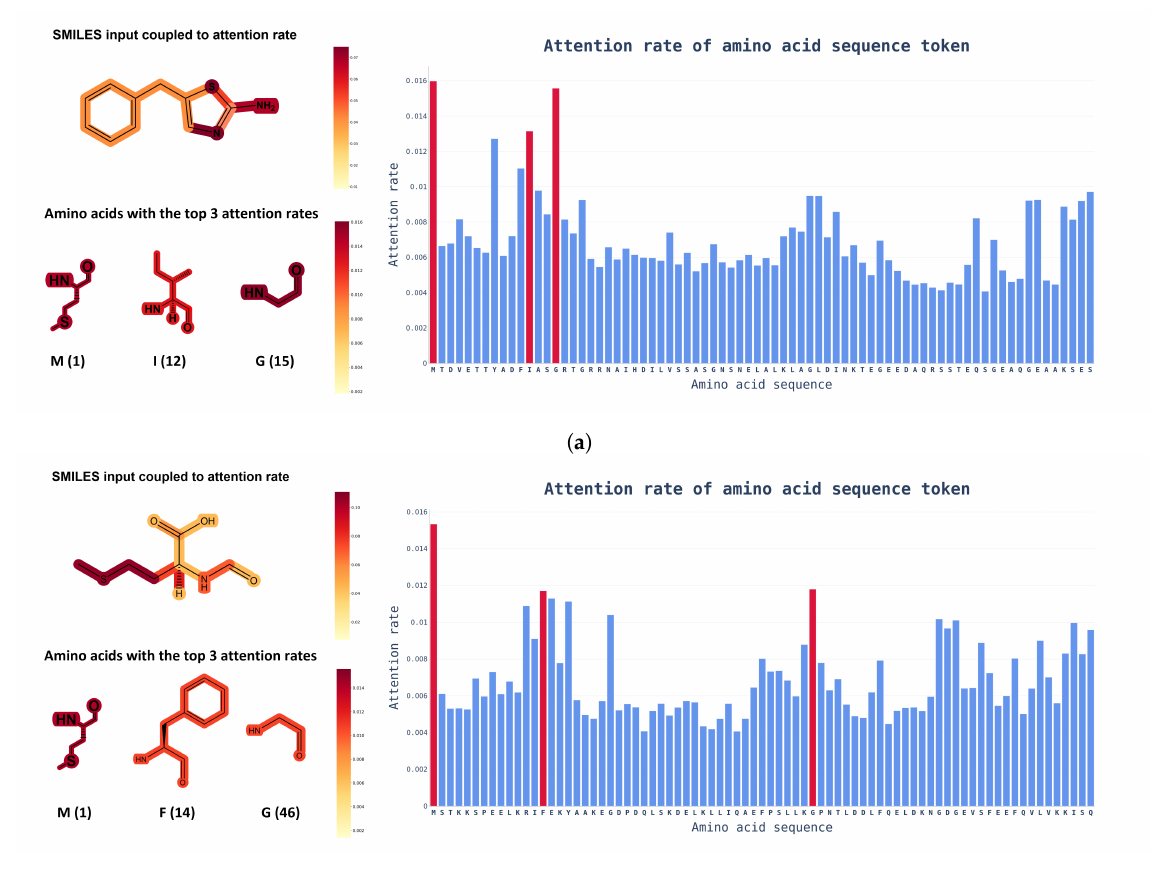
Figure 5. Examples of chemical structural formulas of drugs and proteins with attention weights in the integration dataset. The color bar on the right indicates the attention scores of ChemBERTa and ProtBert. In the amino acid sequence, only the chemical structural formula of the top three amino acids with the highest attention weights are shown, along with position information for readability. ( a ) Attention score of a protein paired with 5-benzylthiazol-2-amine (DTI prediction score: 0.7744); ( b ) Attention score of a protein paired with formyl-L-methionine (DTI prediction score: